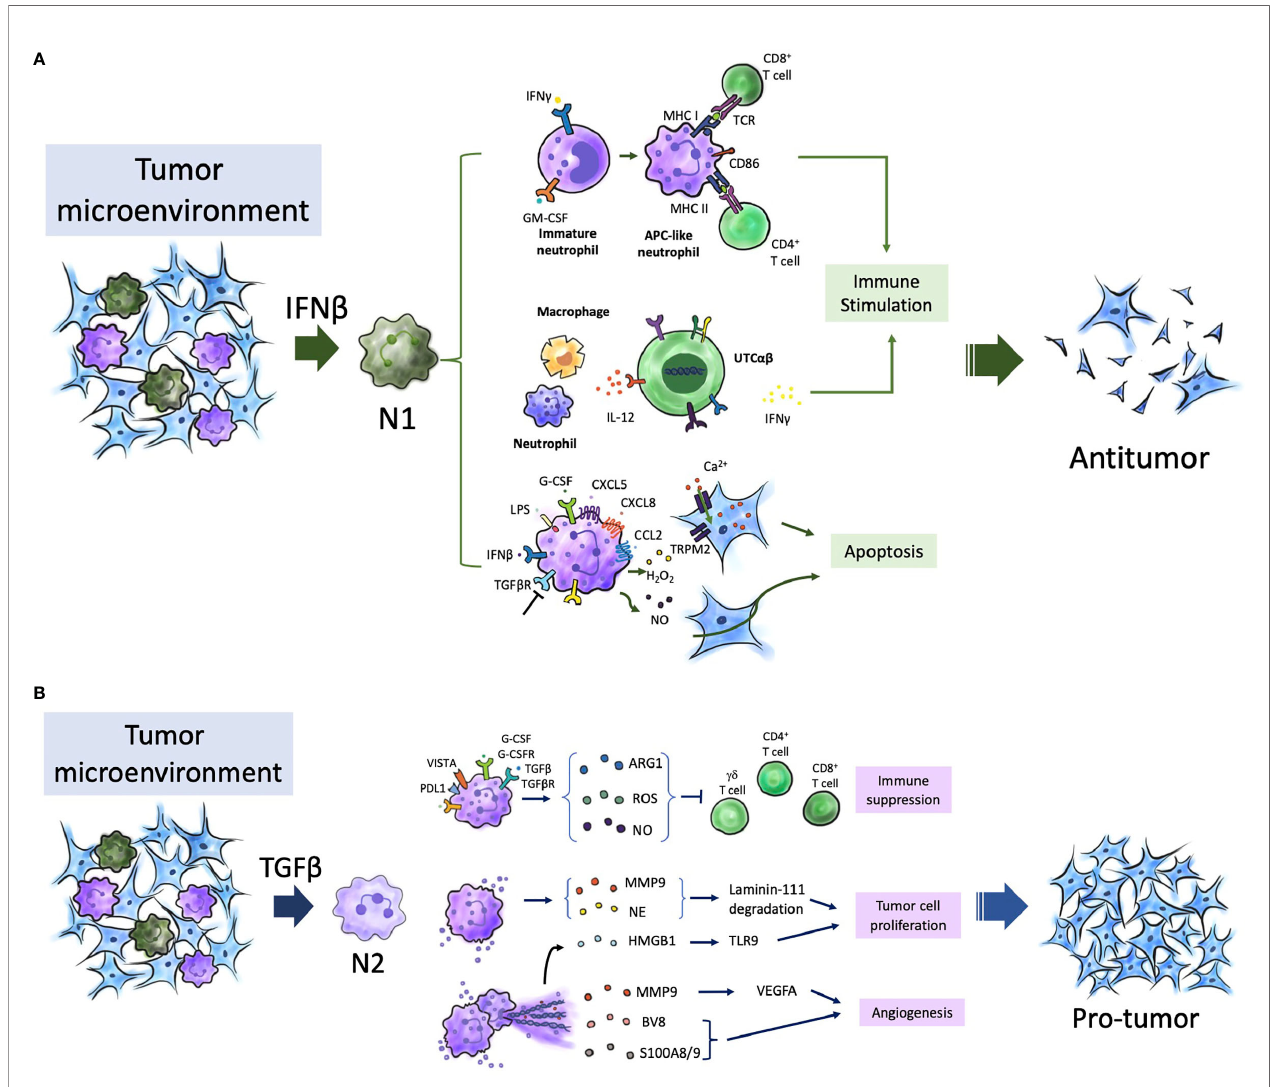
FIGURE 2 | Neutrophils intumor microenvironment. TANs participateindifferentstagesoftumorigenesis,andarepolarizedintoN2(pro-tumor)inthepresence ofTGF- b , and polarizedintoN1(antitumor) inthepresenceofIFN- b intheTME. (A) APC-like neutrophils fromimmatureneutrophilswithpresenceofGM-CSFandIFN g expressMHCI/IIandthe co-stimulatorymolecules CD86,4-1BBligand(4-1BBL) andOX40ligand(OX40L), whichenhanceTcellimmunity. UTC ab , essentialfor effectiveantitumorimmunity, canbe polarizedtoatype1immuneresponseandIFN g productionthroughIL-12productionfrommacrophagewhichwas ampli fi edbyneutrophils. Differentstimuli(G-CSF)and chemokines ofCXCL5/8, andCCL2, LPS, andIFN b promote anoxidativeburstandtheproductionofhydrogenperoxide(H 2 O 2 ),aswellas blockingTGF b pathway. Collectively, H 2 O 2 triggerstheactivationandopeningofTRPM2,andfurther leads toa lethalin fl ux ofcalcium (Ca 2+ ) intotumor cells. (B) N2phenotypepromotedthetumorgrowth, angiogenesis, andimmunosuppression. Neutrophilsexpressimmunecheckpoint receptor ofPDL1 andVISTA. TheyalsohavebeenshownexpressionofARG1,ROS,andNO inthepresenceofG-CSFandTGF b inTME,whichinactivateTcells.HMGB1 fromthereleaseofNETscanactivateTLR9-depedentpathwaywhichsustaintumor cells proliferation. NEandMMP9cleavelaminin-111,andthencleavedlaminin-111triggerstheproliferationoftumor cells throughactivationofintegrinsignaling. Neutrophilspromote angiogenesis throughtherelease ofthepro-angiogenicfactorsBV8,S100A8/9, andMMP9thatactivateVEGFA.TANs,tumor-associatedneutrophils;IFN- b , Interferon- b ; TGF- b , transforminggrowthfactor- b ;TME, tumor microenvironment; GM-CSF,granulocyte – macrophagecolony-stimulatingfactor;IFN g , Interferon- g ;CXCL5/8, CXC-chemokineligand 5/8; CCL2,CC-chemokine ligand2;LPS,lipopolysaccharide;TRPM2, transientreceptor potentialcationchannel, subfamilyM,member 2; UTC ab , CD4 – CD8 – TCR ab + double- negativeunconventionalTcells;PDL1,programmedcelldeath1 ligand1;VISTA,andV-domainimmunoglobulinsuppressor ofTcellactivation;Arg-1,arginase1;ROS,reactive oxygenspecies; NO, nitricoxide; G-CSF, granulocytecolony-stimulating factor; HMGB1,highmobilitygroupprotein1;NETs,Neutrophilextracellular traps; TLR9, Toll-like receptor 9;NE, neutrophilelastase; MMP9matrix